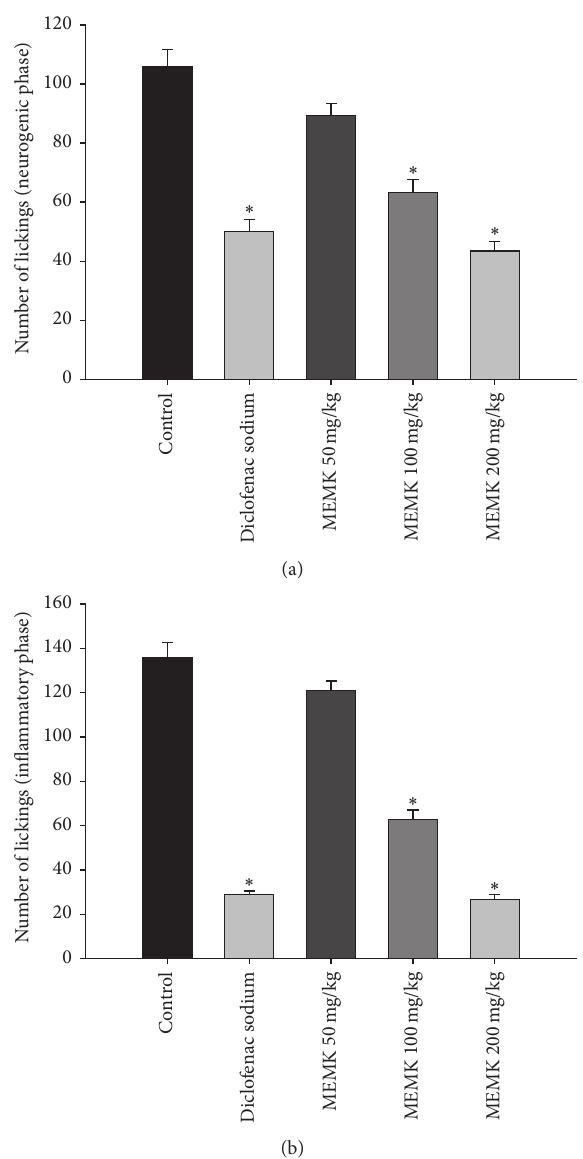
Figure 1: Response frequencies of the right hind paws injected with 2.5%formalininearlyphase(a)andinlatephase(b)offormalintest. Each group represents the mean ± SEM ( 𝑛 = 5–7). Statistical analysis was performed using one-way ANOVA followed by Dunnett’s post hoc test. ∗ 𝑝 < 0.01 compared to